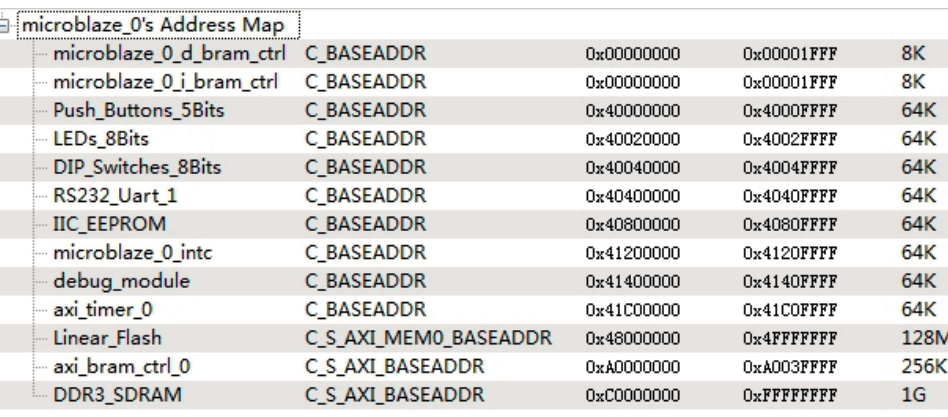
Figure 5. System memory map of BIST